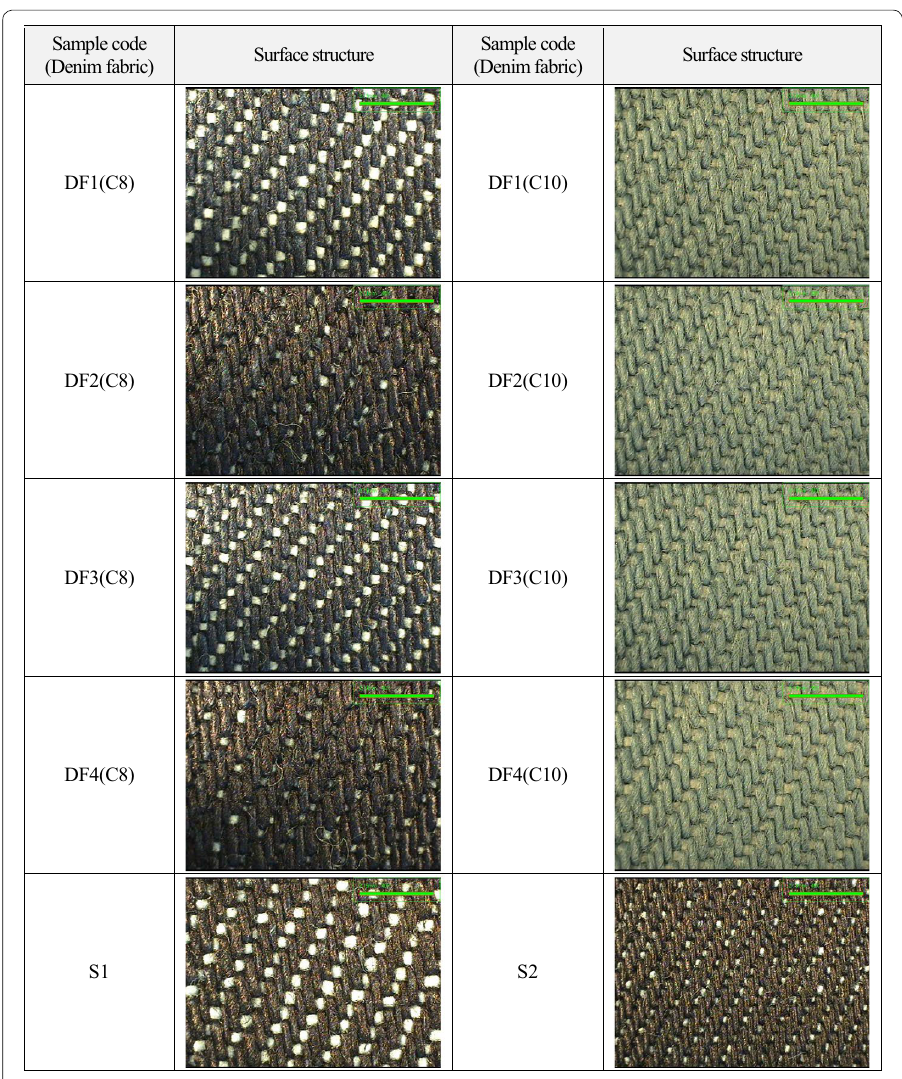
Fig. 4 Photographs of the surface structure of Hanji denim fabrics (